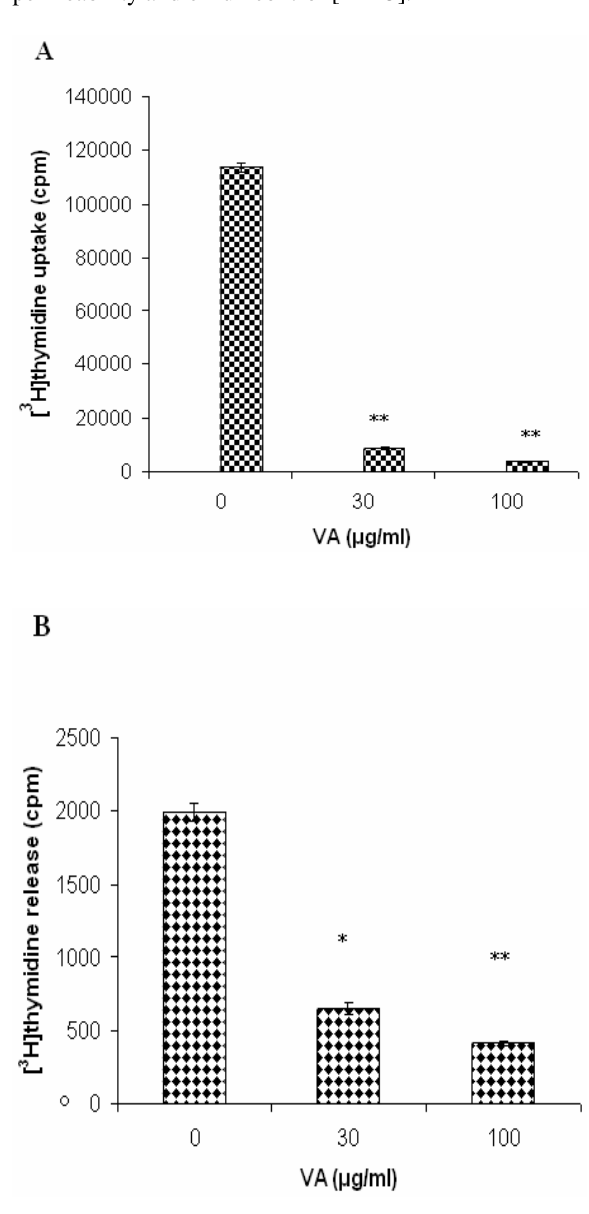
Figure 4: Effects of V. amygdalina treatment on membrane permeability and efflux. Cells at logarithmic growth phase were treated with various (0, 30, and 100 µg/ml) VA for 18 h followed 6 h treatment of 1 µCi/ml [ 3 H]thymidine. The membrane permeability and efflux was section. Each data point represents the mean ± SEM of three independent experiments. *p < 0.05; **p <